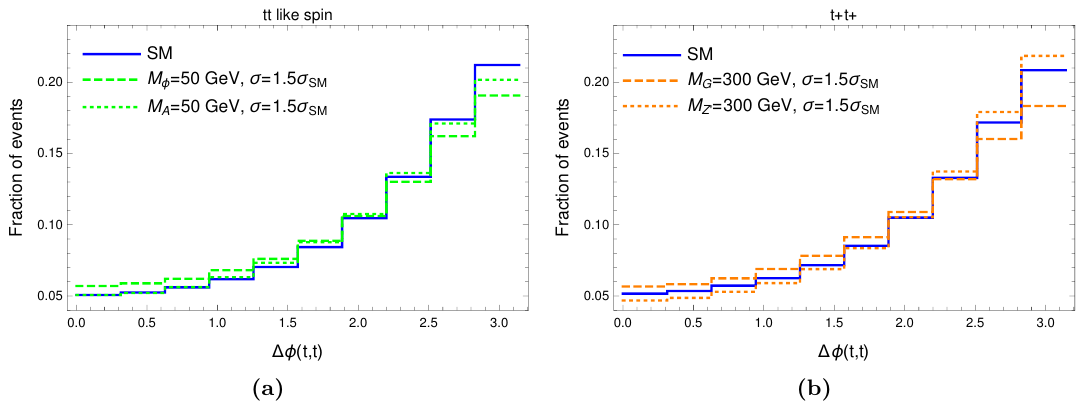
Figure 6. Distribution of the azimuthal separation between the same-sign top quarks, (cid:1) (cid:30) ( t; t ), normalized to unit area. Shown are the predictions for the SM (blue) and the tight benchmark points (i.e. giving (cid:27) = 1 : 5 (cid:27) SM ) of the NP models considered for the dominant helicity con(cid:12)gurations: (a) Scalar and Pseudo-scalar, (b) Z 0 and